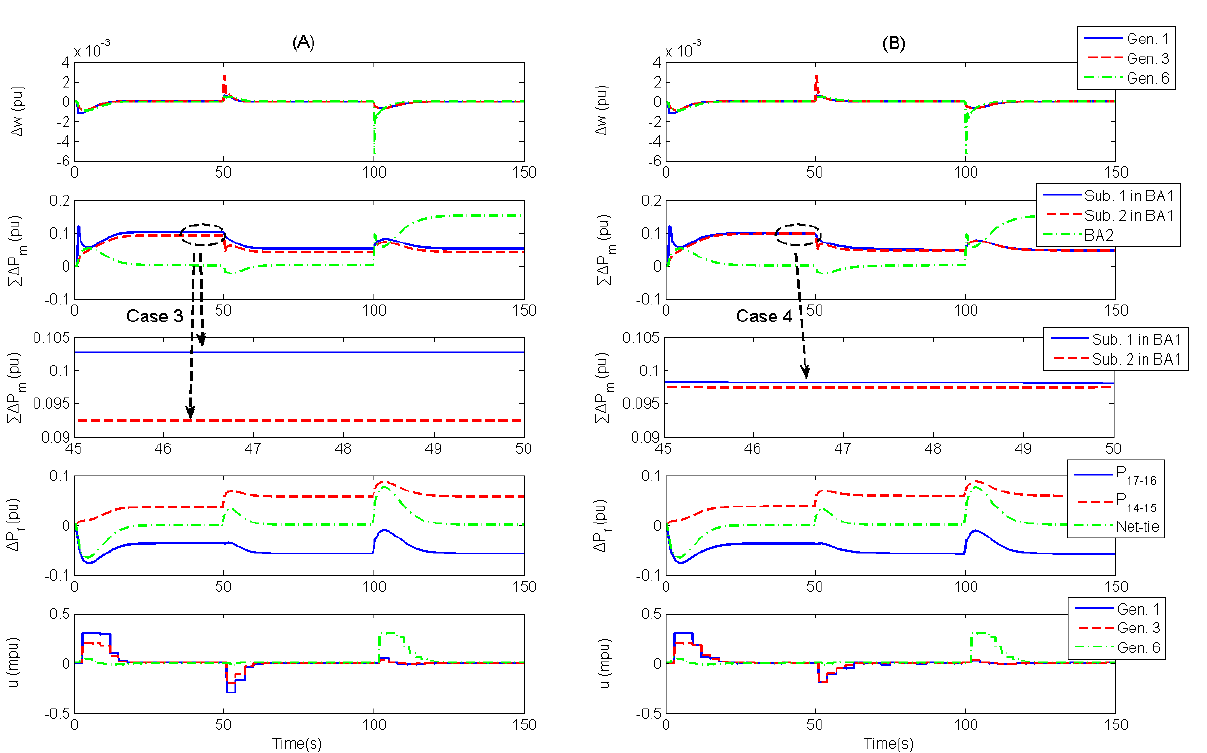
Figure 5. Distributed MPC-based AGC: ( A ) Without Partitioning (Original Case); ( B ) With Partitioning (Proposed